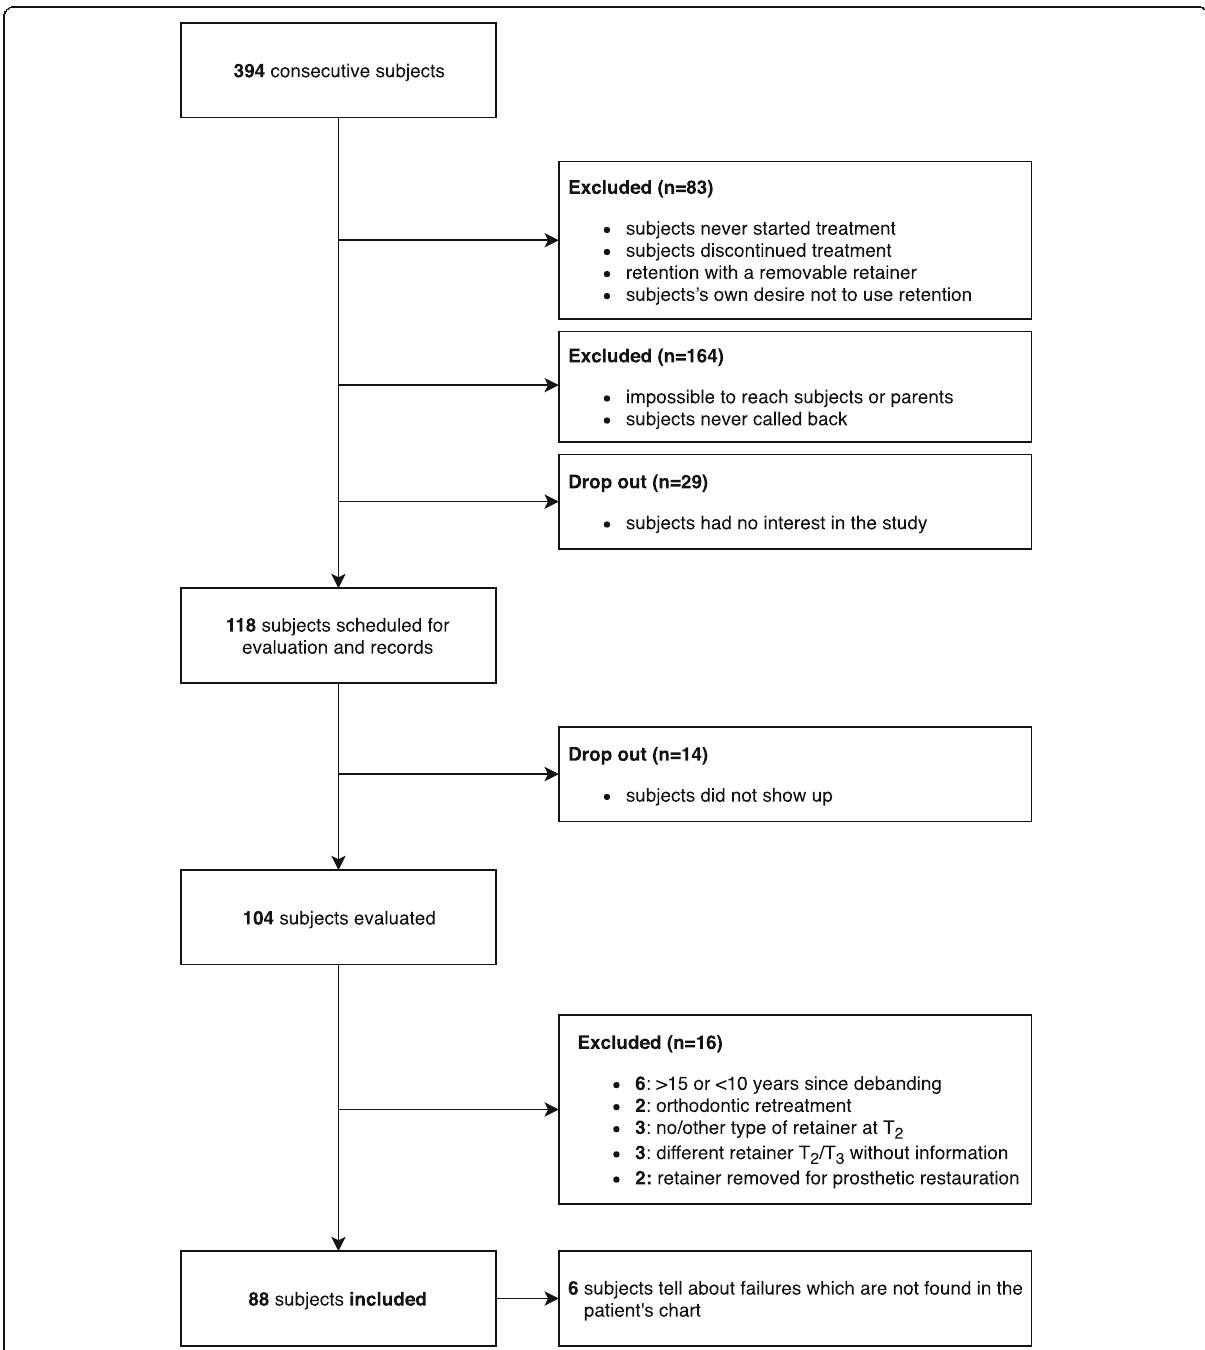
(incisors and canines) (Fig. 2) and (II) .027 ″ round TMA wire bonded to canines only (ORMCO) (Fig.